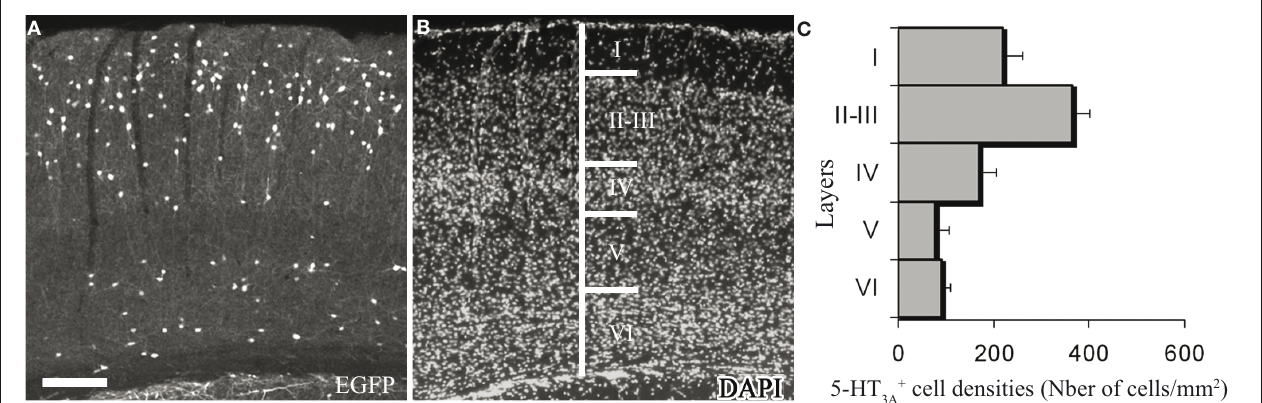
FIGURE 1 | Expression of 5-HT 3A within the somatosensory cortex. (A , B) Coronal section of a 5-HT 3A :GFP mouse counterstained with DAPI showing the preferential location of 5-HT 3A -expressing cells in supragranular